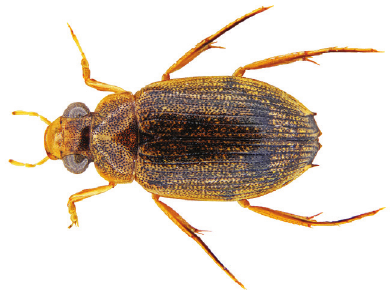
Figure 14. Berosus cuspidatus Erichson, 1843 5.2 mm, iSimangaliso Wetland Park, False Bay (site 29), February 2015 DT Bilton, MS Bird & R Perissinotto leg.